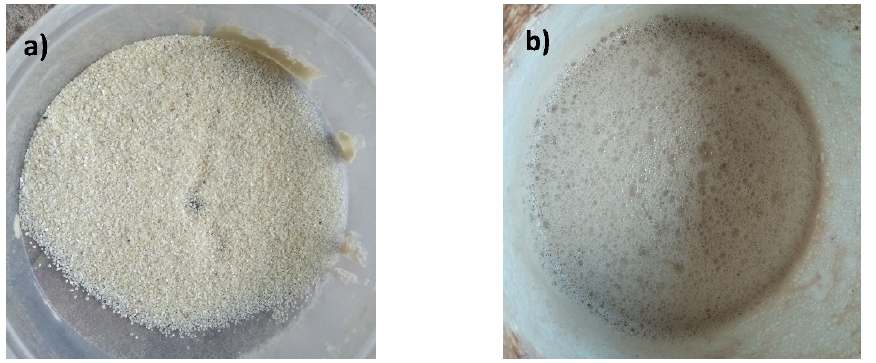
Figure 1. Casein used in the research: ( a ) casein powder, ( b ) casein dissolved in a calcium solution. The mixture was placed in triple molds with dimensions of 40 mm × 40 mm × 160 mm and compacted for 15 s on a vibrating table. The samples were matured under the air-dry conditions (temperature: 21 ◦ C ± 2 ◦ C and relative humidity: 50% ± 5%) for 40 days. After this time, the investigation was carried